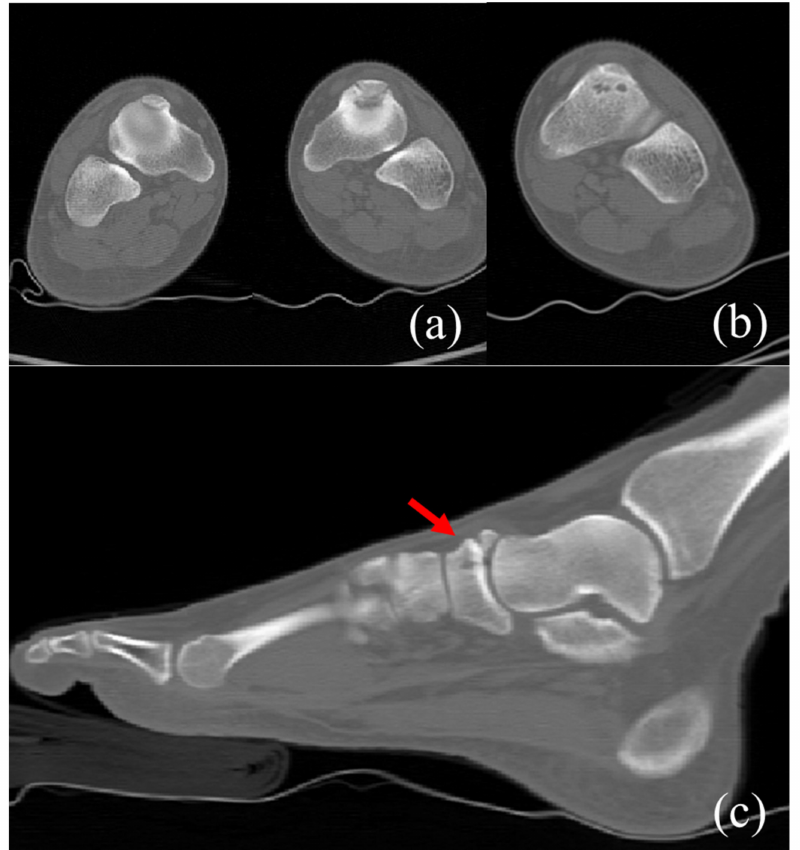
Figure 2. Preoperative coronal CT image ( a ) shows bilateral os supranaviculare situated in osseous depression of dorsal cortex. In the left foot, multiple bony cysts were observed under the cortex of navicular bone in the bilateral feet. In the left foot, multiple bony cysts under sclerotic margin were noted. ( b ) Preoperative sagittal CT image of the left foot ( c ) demonstrates an incomplete fracture line (arrow) extending from dorsoproximal cortex to the center of a